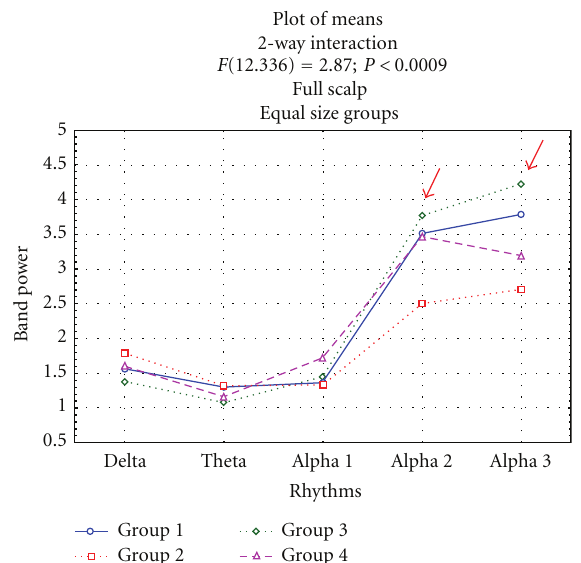
Figure 2: Statistical ANOVA interaction among group factors and relative band powers (delta, theta, alpha1, alpha2, and alpha3), on the full scalp region. The groups are based on mean and standard deviations in a normal elderly sample. Group 1: no hippocampal atrophy; group 2: mild hippocampal atrophy; group 3: moderate hippocampal atrophy; group 4: severe hippocampal atrophy. Post hoc results are indicated in the diagram (see [32,